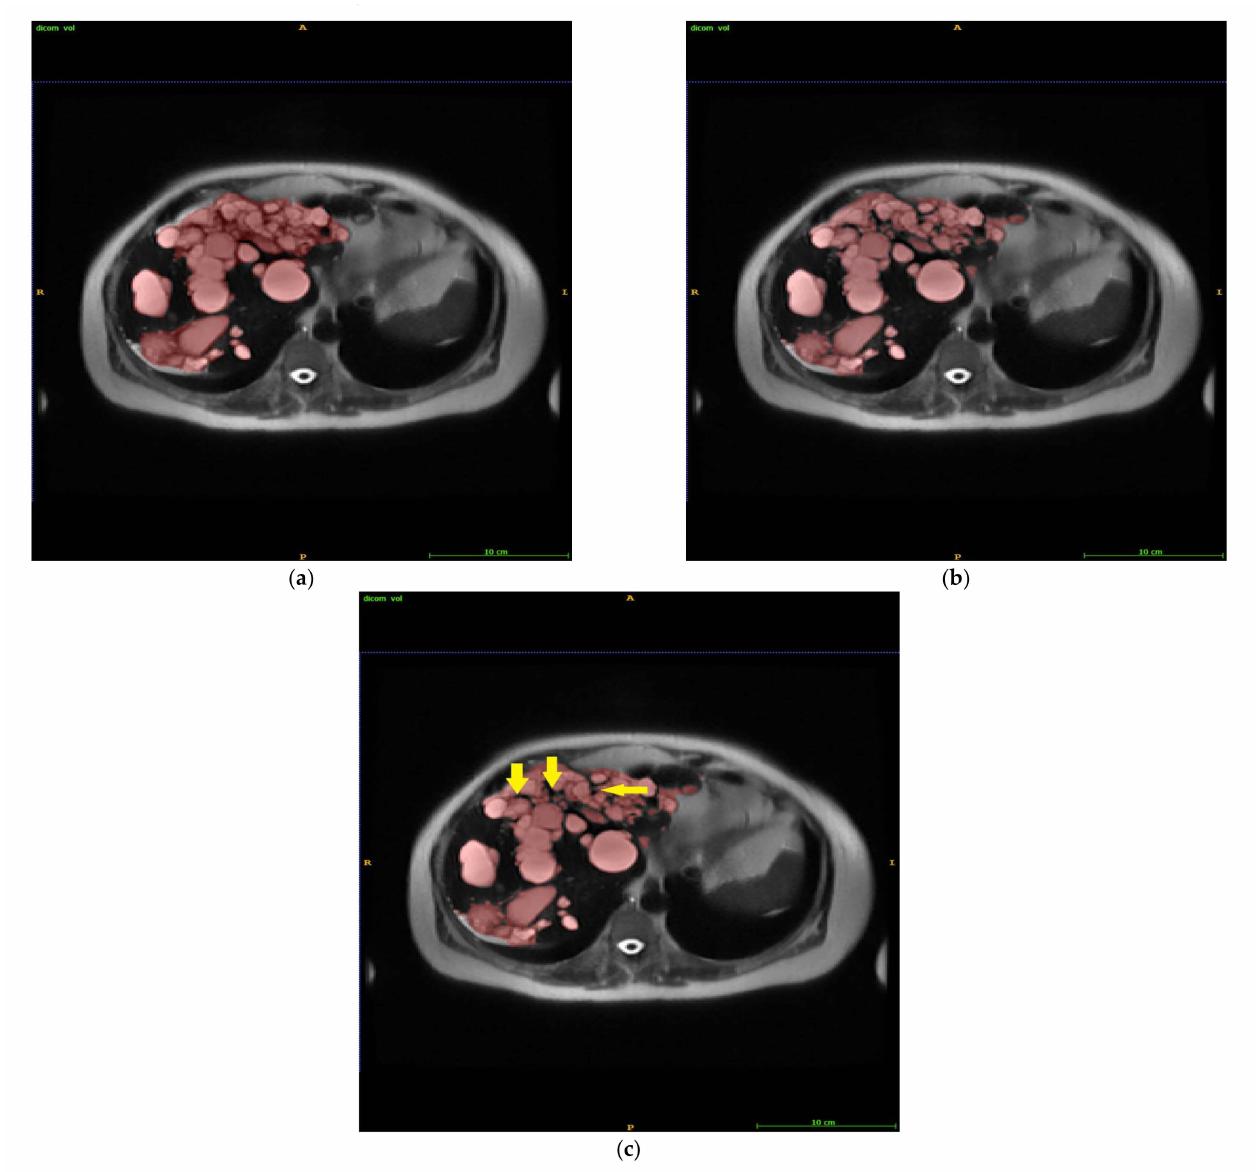
Figure 4. Liver cyst segmentation by manual GT ( a ), automated LS ( b ), and IRIS ( c ). The voxels in the space between neighboring cysts (arrows in ( c )) were easily included in the manual GT, contributing to the observed segmentation errors. GT = ground truth segmentation, LS = automatic level set segmentation, and IRIS = intelligent rapid interactive